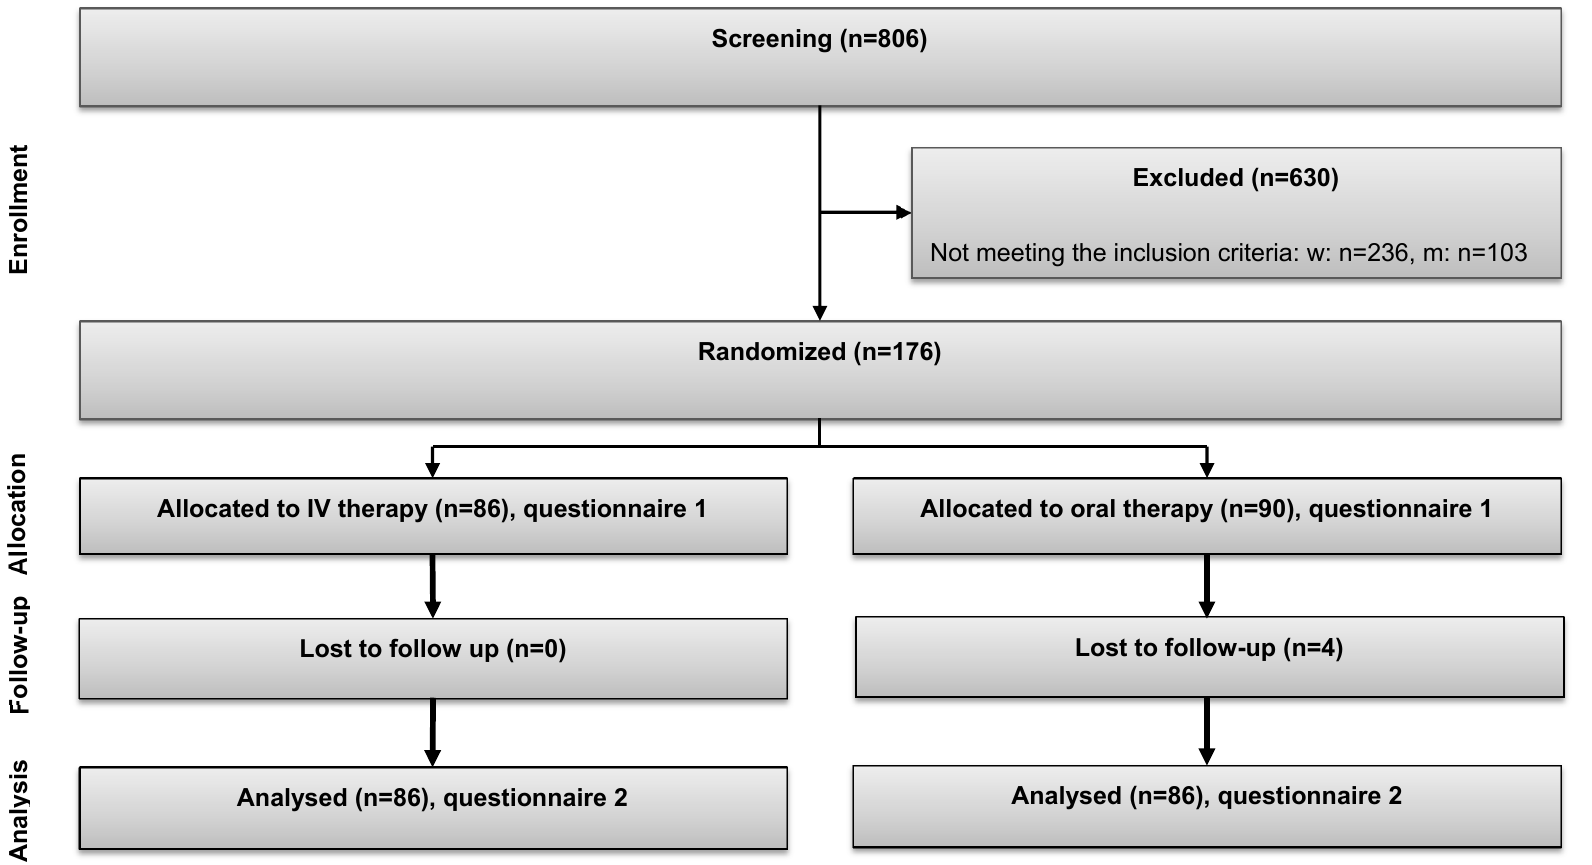
Figure 1. Study Figure 1. Study flowchart.